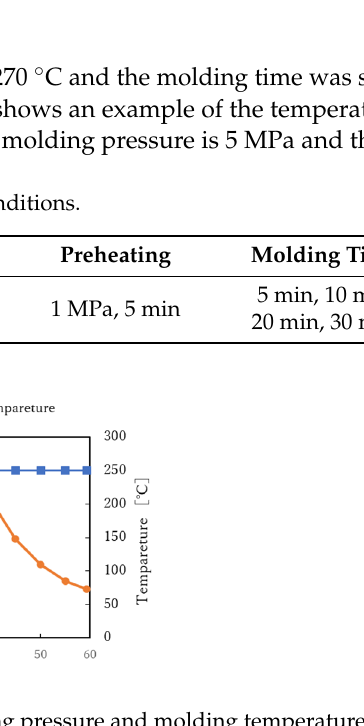
Table 5. Conditions of tensile test.